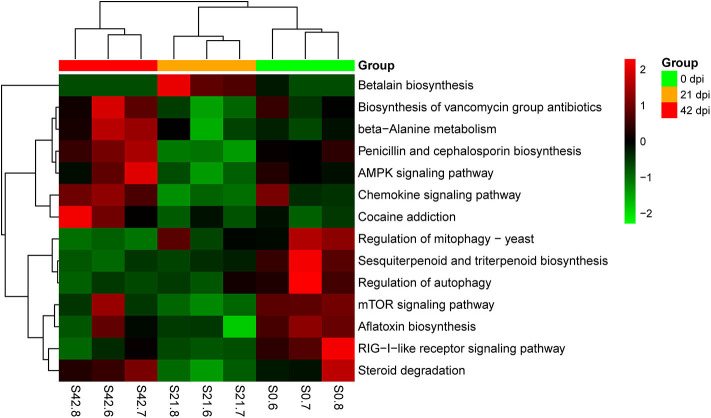
Hierarchical clustering heat map constructed using annotated metagenomic data on the basis of the Kyoto Encyclopedia of Genes and Genomes (KEGG). Samples are shown in columns, and KEGG pathways are shown in rows.